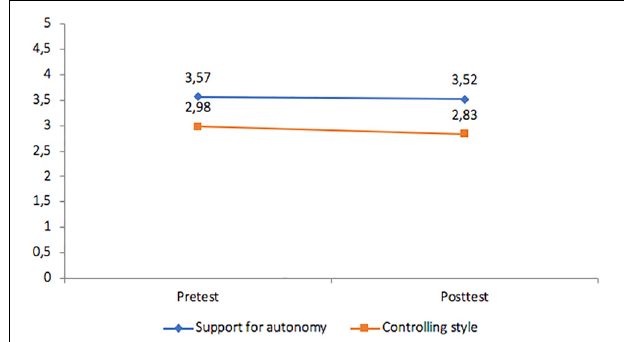
FIGURE 4 | Control group: changes in student perceptions of instructional style.